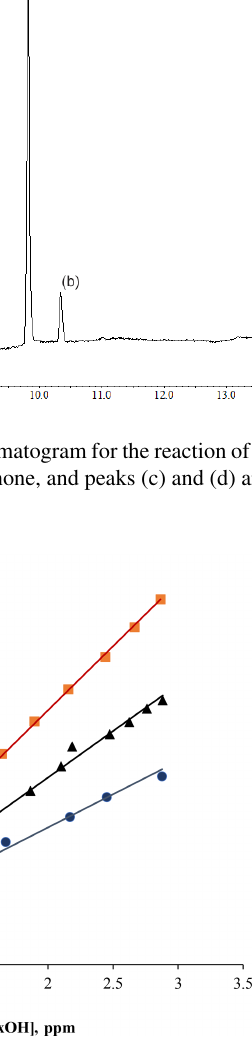
Figure 4. Plots of the corrected concentration of (E)-4- methylcyclohexanone ([(E)-4-methylcyclohexanone] corr ) against 4MCHexOH consumed ( (cid:49) [4MCHexOH]) for Cl atoms (in the ab- sence of NO x ) and OH and NO 3 radical